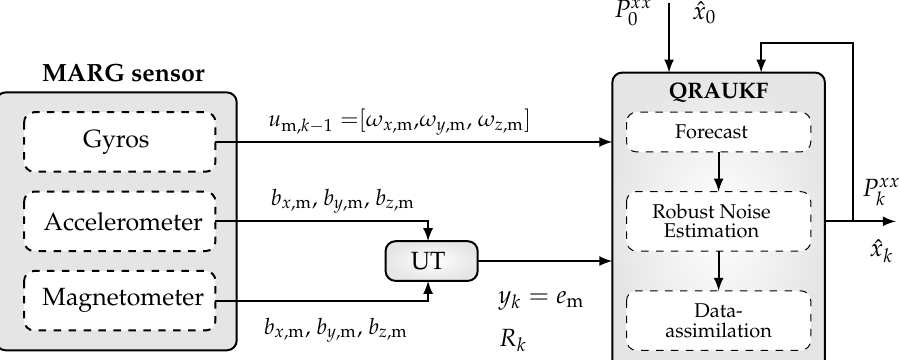
Figure 1. The architecture of the quaternion-based robust adaptive Kalman filter. In the left, the MARG sensor provides the measurement information. The filtering algorithm uses the gyros measurement ω m ∈ R 3 in the forecast step. The UT block is used to propagate the accelerometer a m ∈ R 3 and magnetometer b m ∈ R 3 measurements through a nonlinear function, computing a unit quaternion, used as a pseudo-measurement in the robust noise estimation and data-assimilation